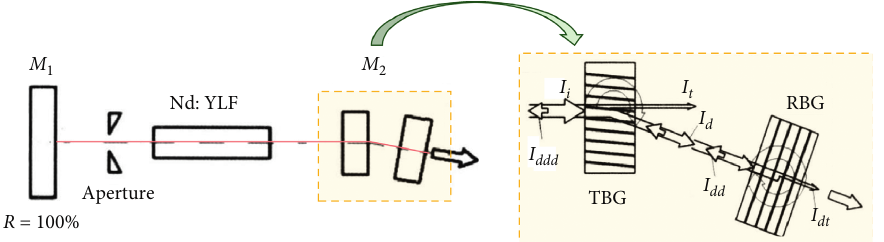
Figure 12: SLM laser based on combined VBGs